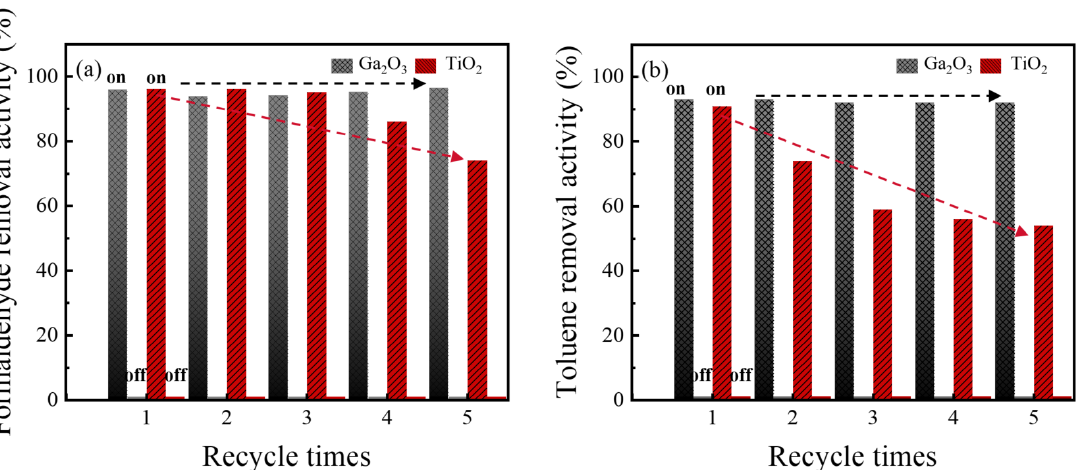
Figure 3. Photocatalytic recycling tests of Ga 2 O 3 and TiO 2 for the degradation of ( a ) formaldehyde and ( b )